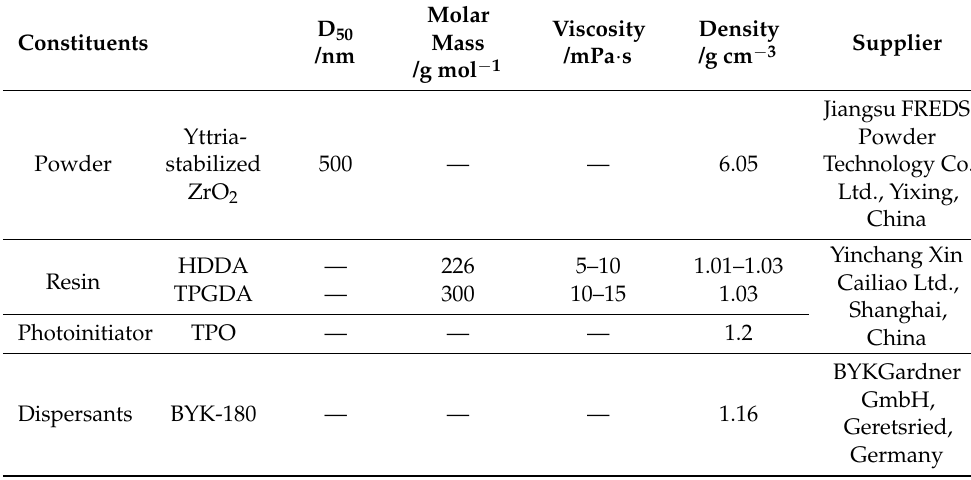
Table 1. Slurry constituents and their properties.